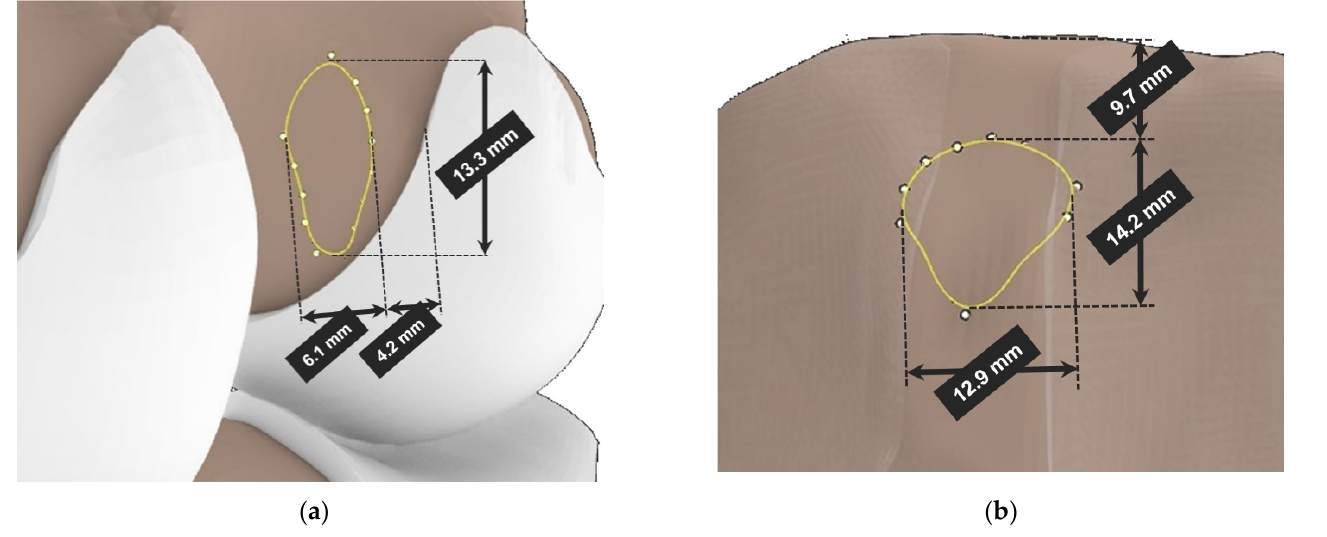
Figure 2. ACL insertion dimensions in the model, ( a ) femoral, ( b ) tibial.